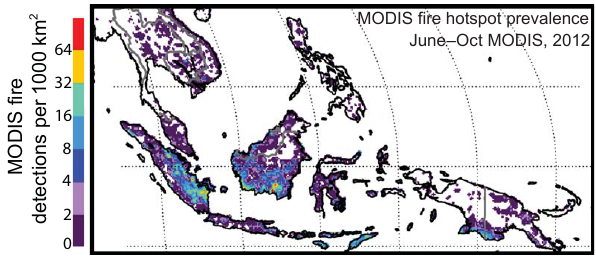
Figure 2. Overall Terra and Aqua MODIS detected fire prevalence for June through October